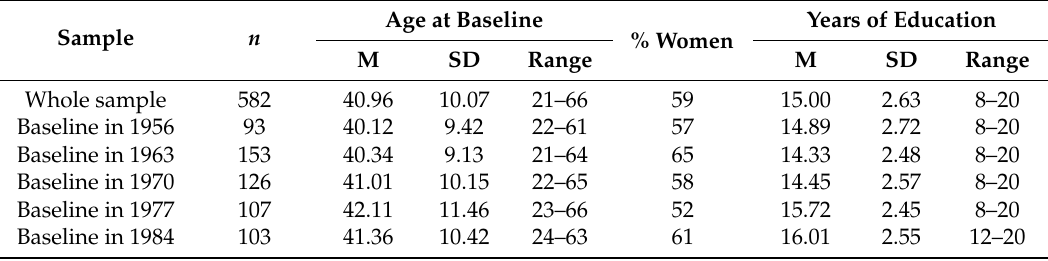
Table 1. Descriptive statistics for sociodemographic